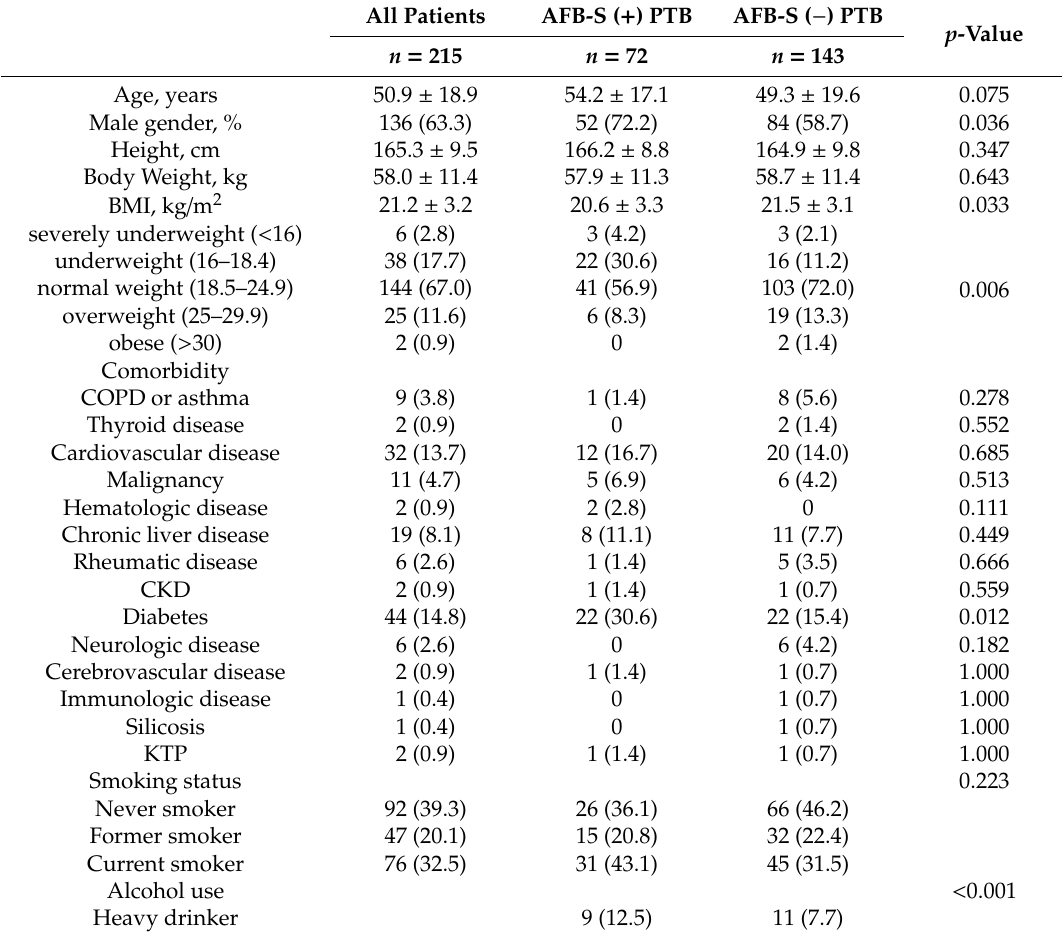
Table 1. Demographic and clinical characteristics of the enrolled 215 patients with PTB. All